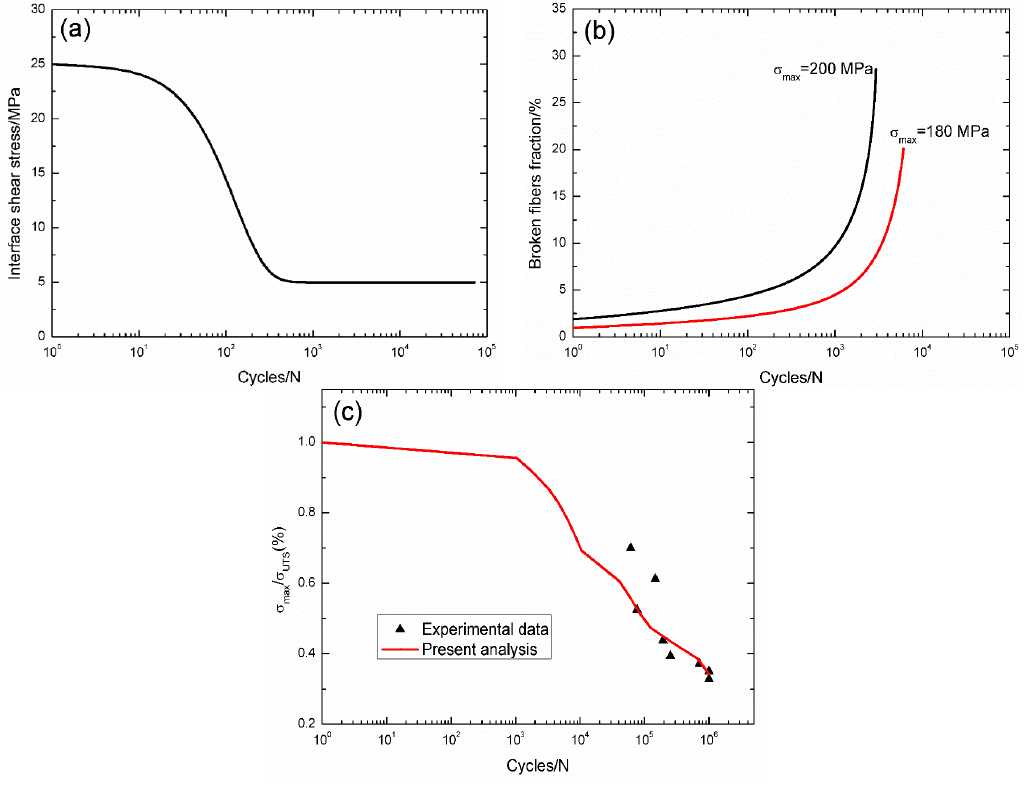
Figure 14. ( a ) The interface shear stress versus applied cycles; ( b ) the broken fiber fraction versus applied cycles; and ( c ) the fatigue life S–N curves of experimental data and theoretical analysis for 2.5D C/SiC composite at 900 °C in air.